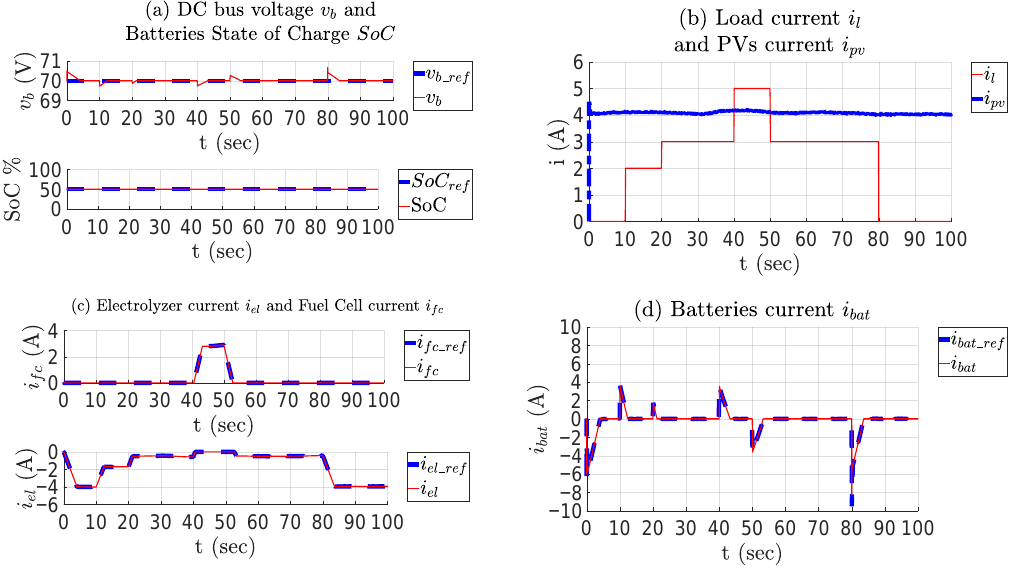
Figure 3. Simulation: SoC ∗ = SoC init , ( a ) DC bus voltage and batteries SoC , ( b ) load and photovoltaics currents, ( c ) fuel cell and electrolyzer current and ( d ) batteries energy storage system